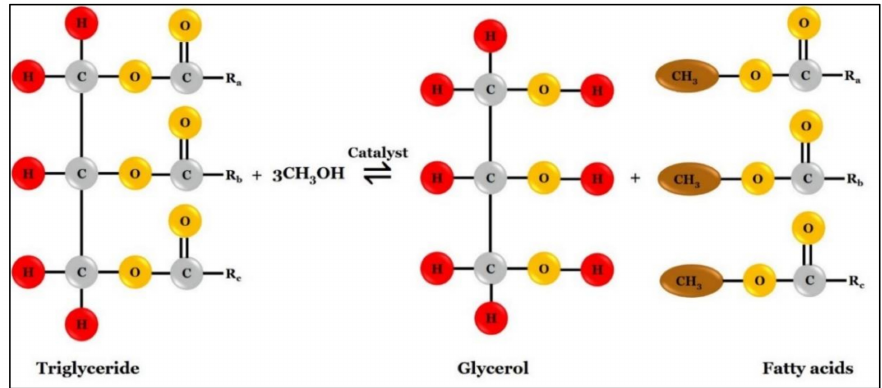
Figure 1. The transesterification process for biodiesel production